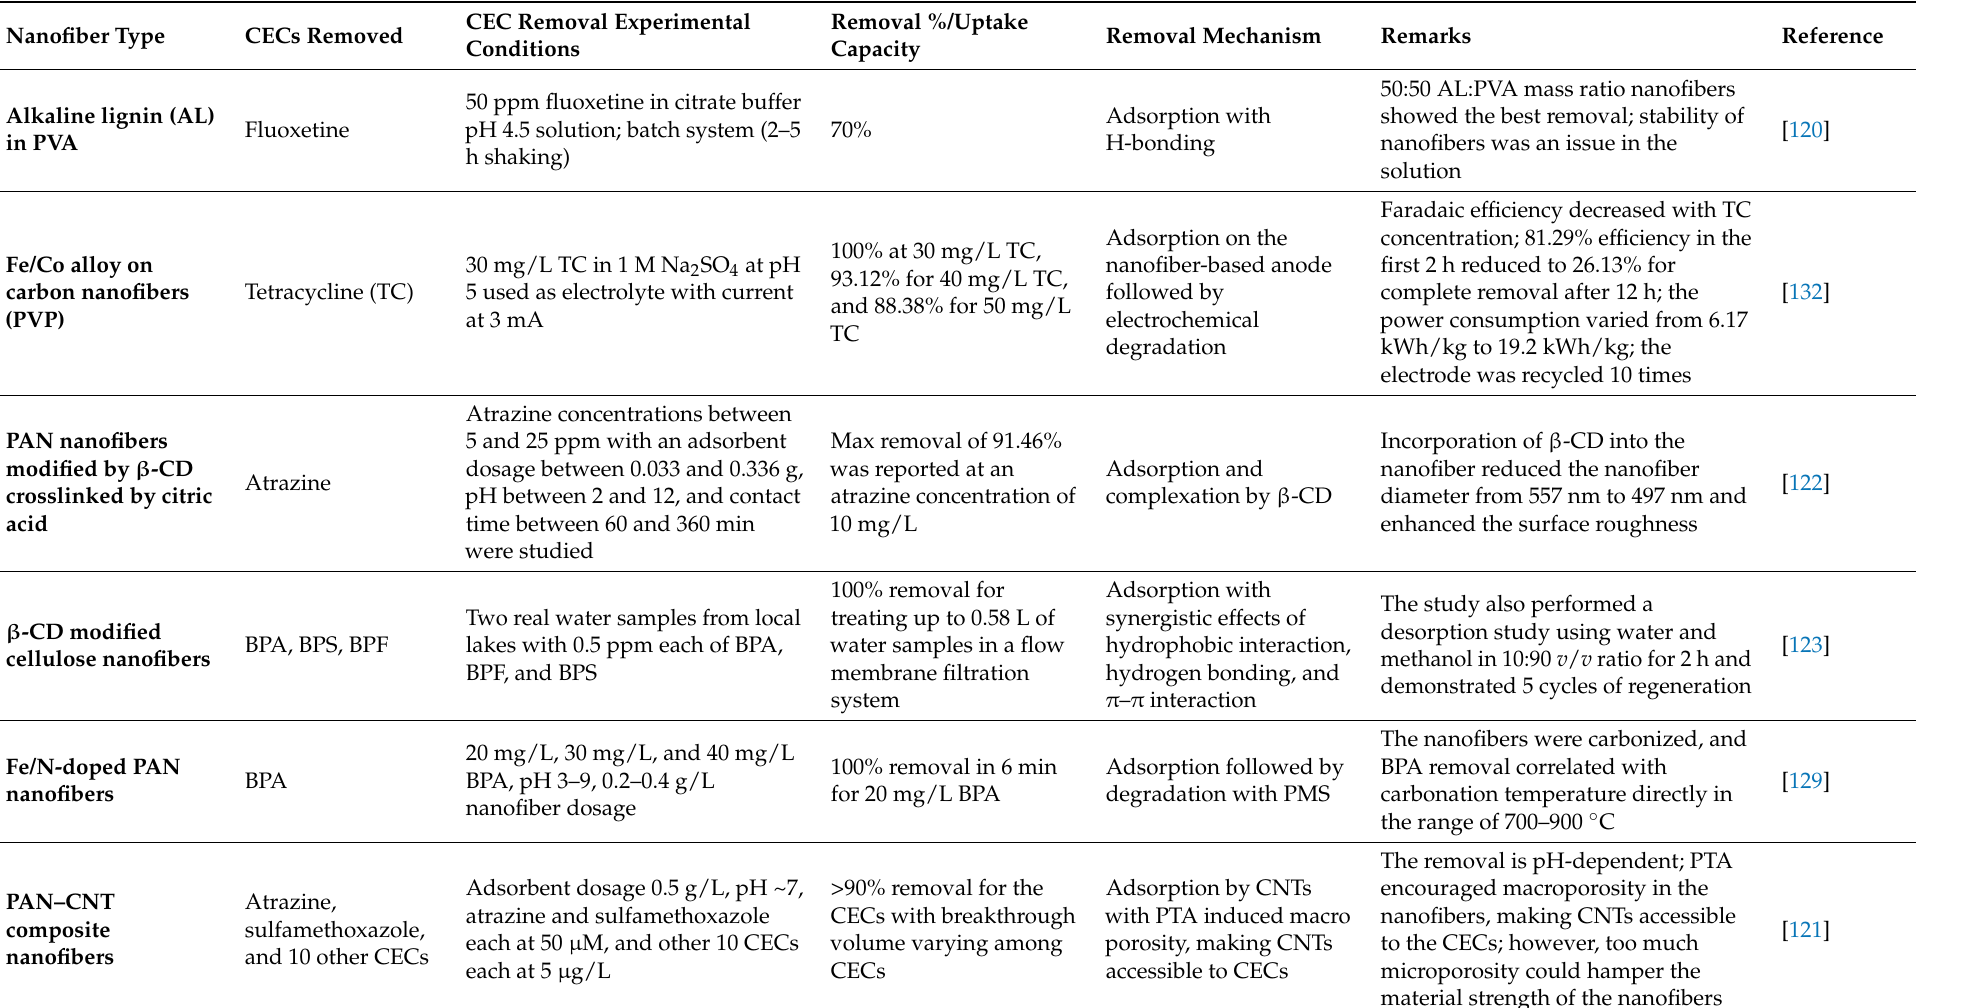
Table 4. A summary of CEC remediation using